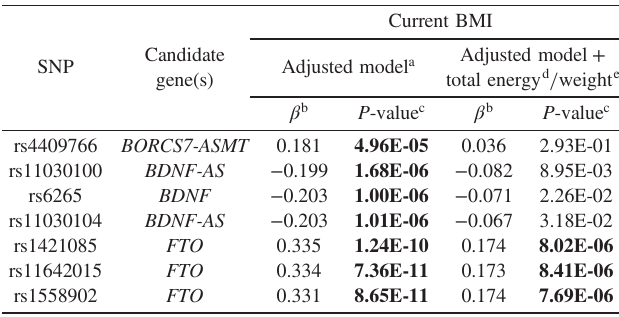
Table 4. Seven identi fi ed SNPs associated with the current BMI adjusted for total energy